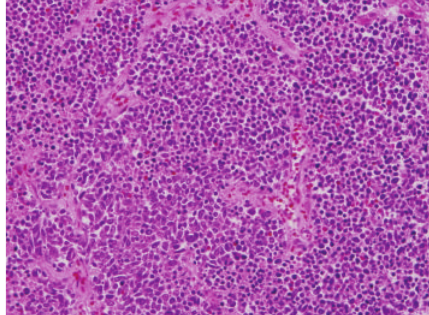
Figure 6: Autopsy of the liver on high magnification showing areas of poorly differentiated squamous cell carcinoma (high power